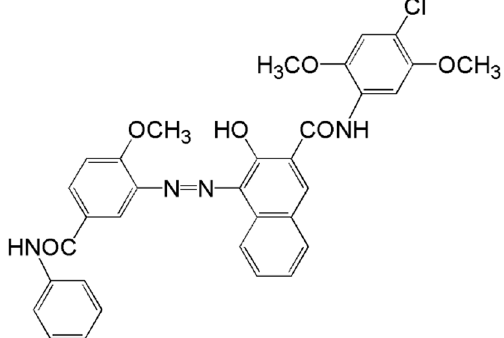
Figure 1. Chemical structure of C.I. pigment red 146.